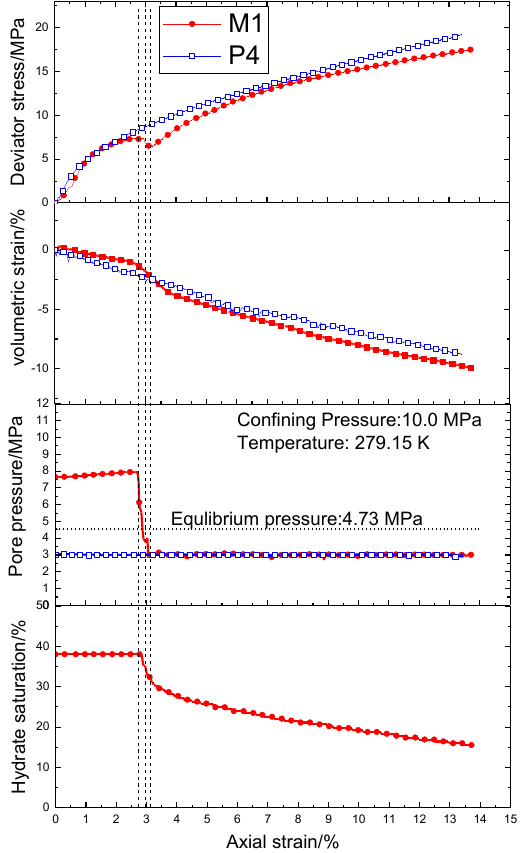
Figure 3. Relationships of deviator stress, volumetric strain, pore pressure, and methane hydrate saturation to axial strain of methane hydrate-bearing sediments dissociated by the depressurization method.